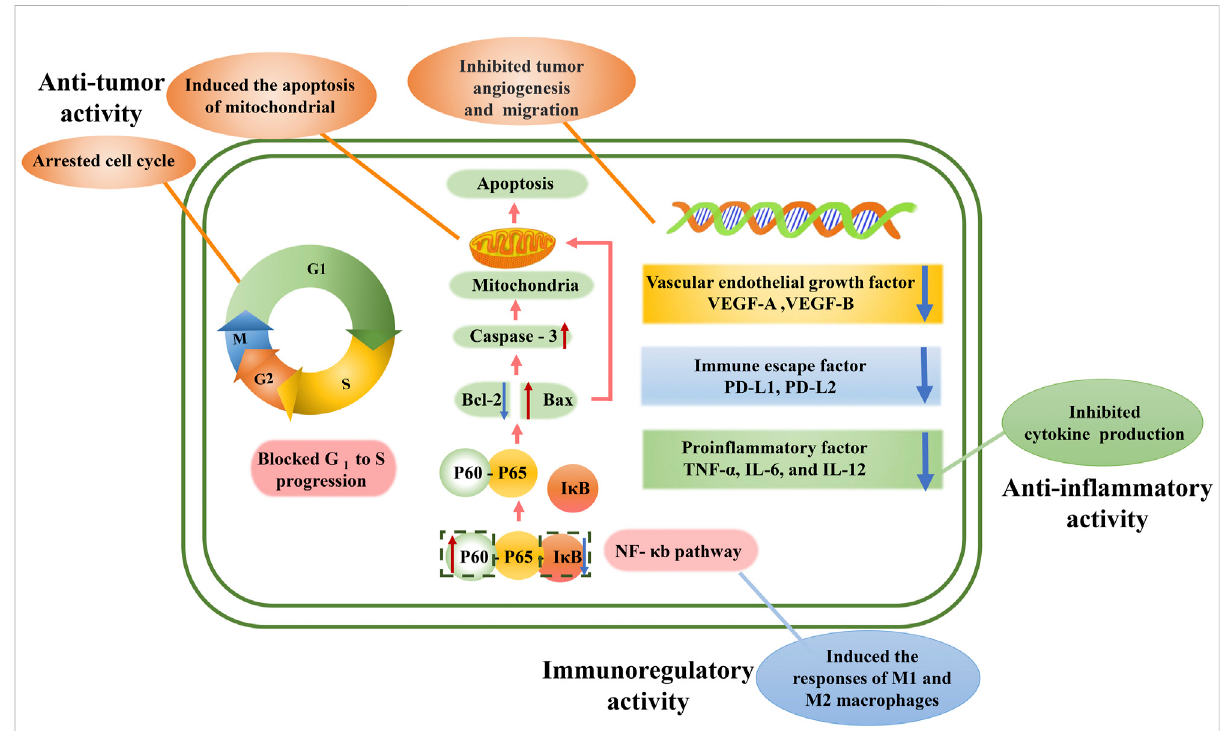
FIGURE 8 Possible mechanism of anti-tumor, immunoregulatory, and anti-in fl ammatory activities of A. eriantha . S, Synthesis phase, G, Gap phase, M, mitoticperiod.AEinhibitedtumordevelopmentthrougharrestingcellcycle,inducingapoptosisandinhibitingtumorangiogenesisandmigration.AE regulated immunitythroughinducingtheresponsesofM1andM2macrophages.AEexhibited anti-in fl ammatoryactivitythroughinhibitingcytokine